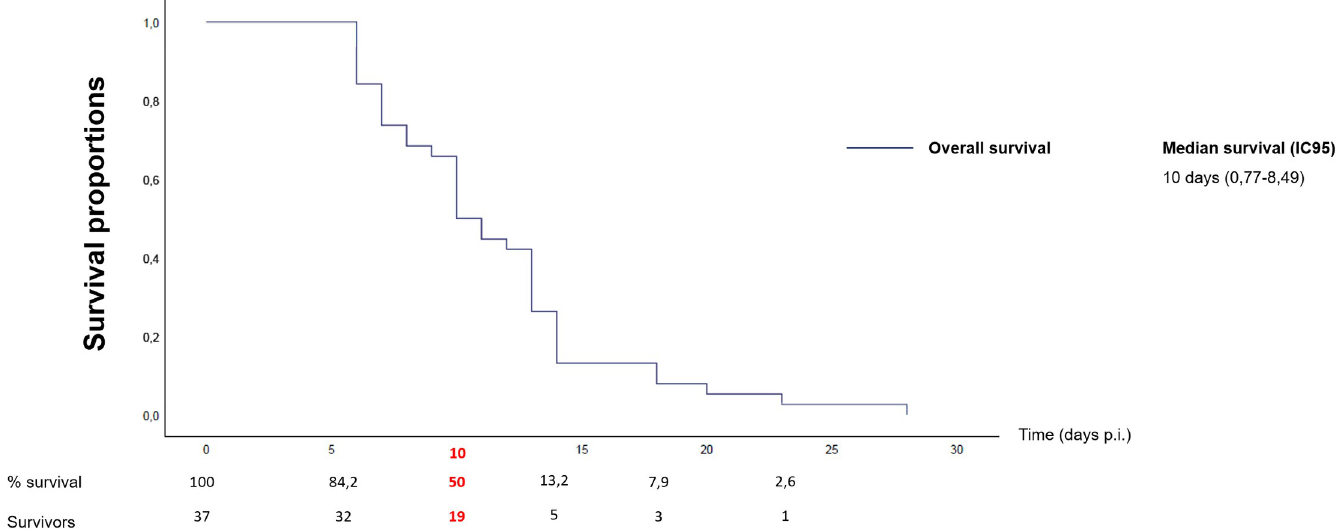
Fig 2. Survival curve of Swiss mice infected by Africa 1 strains from